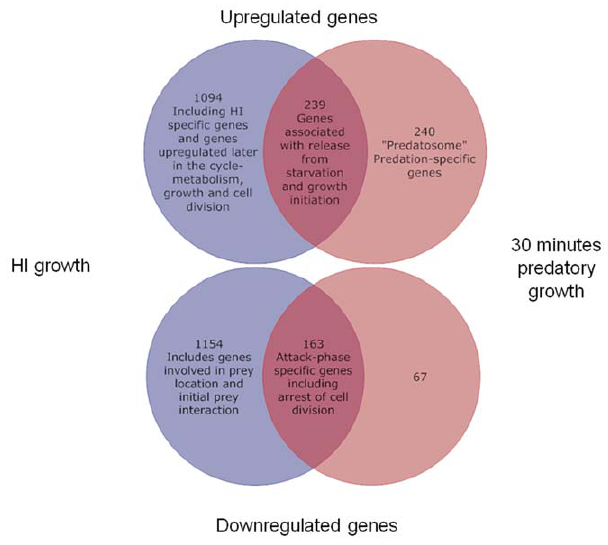
Figure 2. Combining Attack-phase, HI and Predatory Datasets. Venn diagram produced by combining our datasets in a comparison of genes up or down-regulated in 30 minutes predation versus attack- phase and those up or down regulated in HI growth versus attack phase. This allows identification of gene expression patterns specific to each growth state- 30 minutes predation, attack-phase outside prey, or axenic HI growth without prey. For example 240 genes that are specifically up-regulated only upon 30 minutes predation, compared to attack phase; are delineated away from a set, of 239 ‘‘release from starvation and growth initiation’’ genes that are up-regulated both in predation and HI growth, compared to non-replicative attack-phase Bdellovibrio